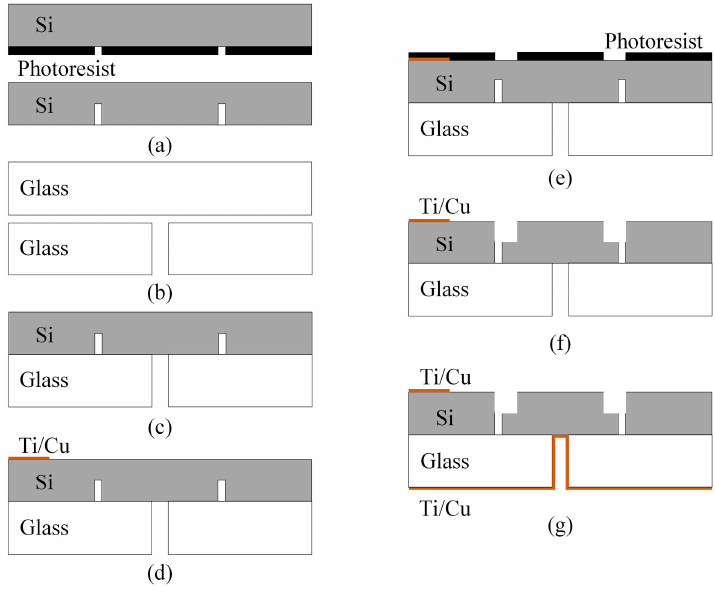
Figure 4. The main steps of fabrication of the miniature ion source